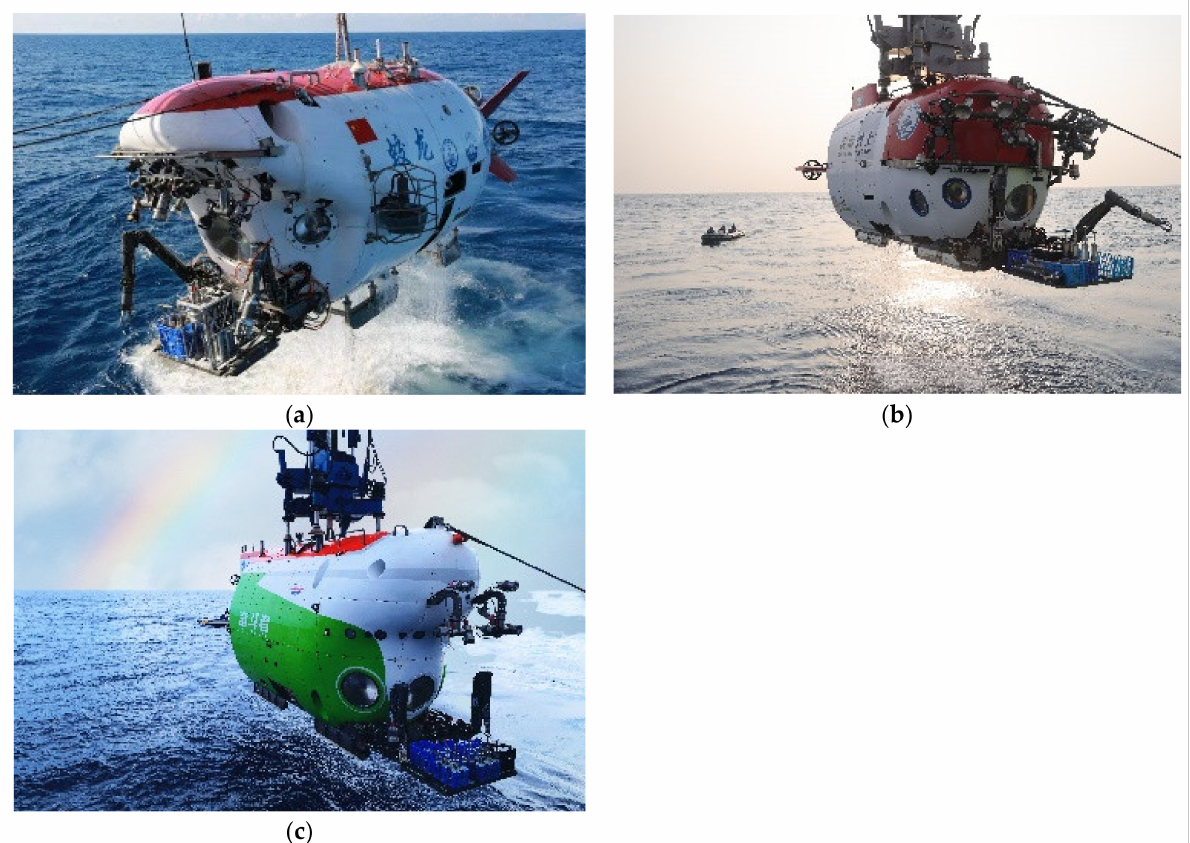
Figure 1. Chinese human occupied vehicles: ( a ) the Jiaolong HOV, ( b ) the Shenhai Yongshi HOV and ( c ) the Fendouzhe